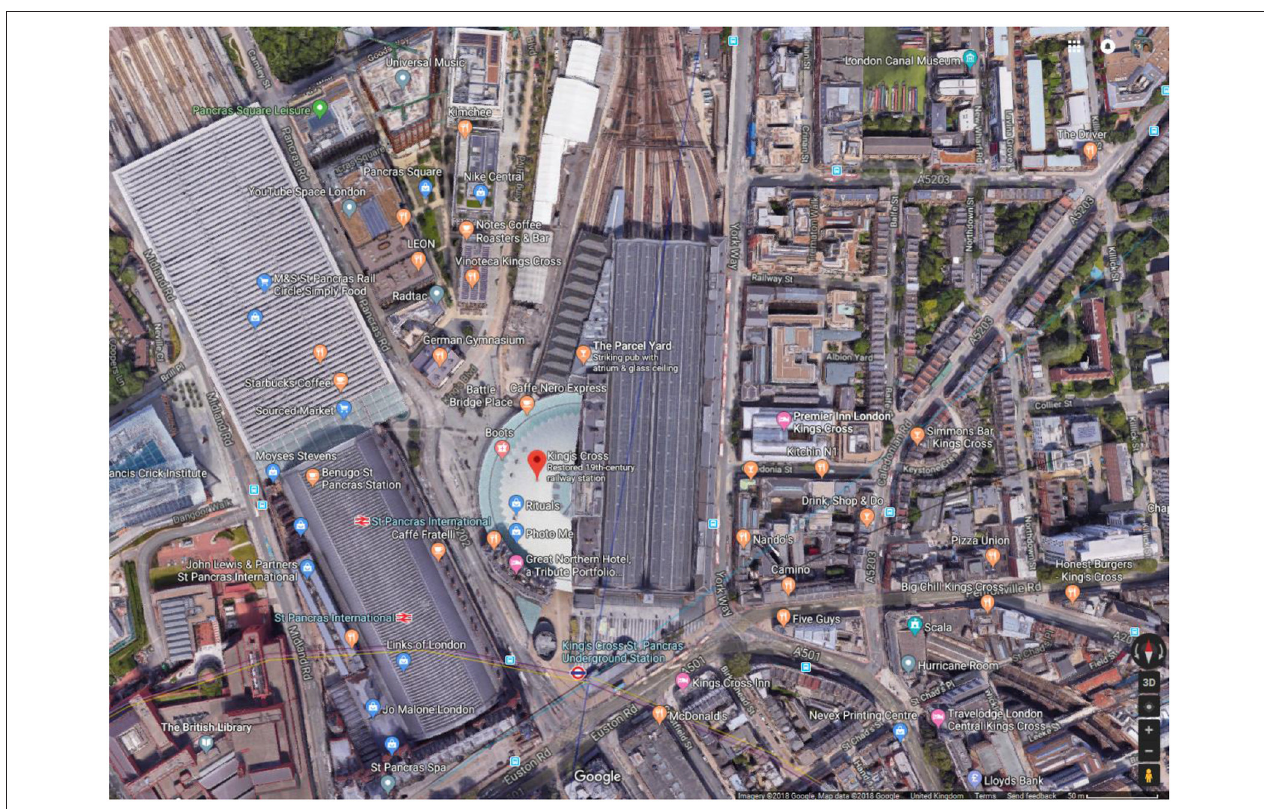
FIGURE 1 | Location site of King’s Cross station (Google Map,